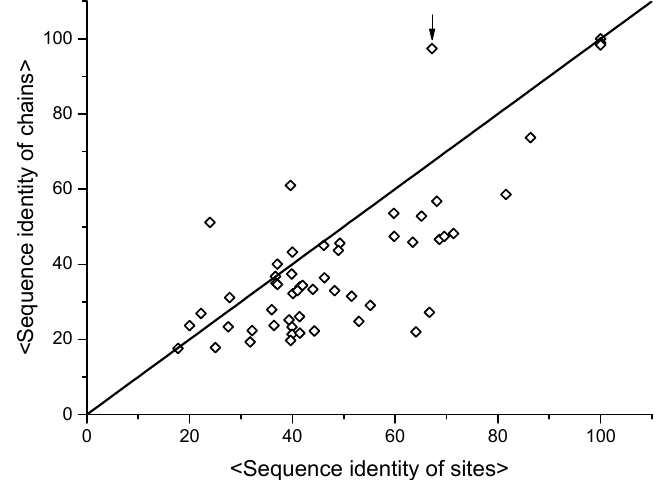
Figure 8. Comparison of sequence identity values within clusters of representative MFSs vs. sequence identity values of the corresponding protein chains. Heme-binding MFSs have been clustered using the approach of Figure 6. For each cluster, the pairwise sequence identity values between all sites have been computed from the structure-based alignment of the MFSs, and their average is reported on the x axis. The y axis instead reports the average sequence identity values obtained from the pairwise alignment of the protein chains containing the MFSs in each cluster. The continuous line corresponds to the function y = x ; thus, points below the line correspond to clusters for which the average sequence identity of MFSs is higher than the average sequence identity of the proteins containing them. The point highlighted by the arrow corresponds to a cluster containing the MFSs from a single protein (multi-heme cytochrome c ) with multiple repeats, plus another site. The y coordinate for this cluster is close to 100% because it includes the contribution due to the entire protein chain being aligned to itself.